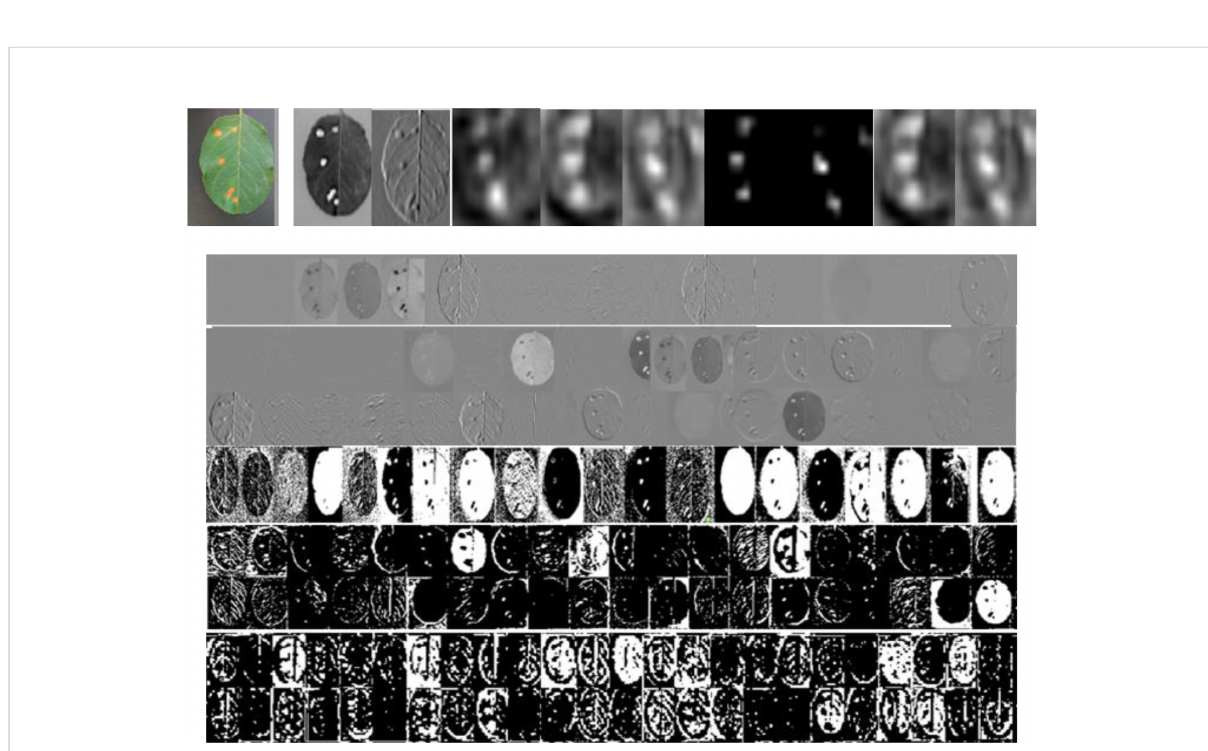
FIGURE 8 An original image and its feature map examples in different convolutional